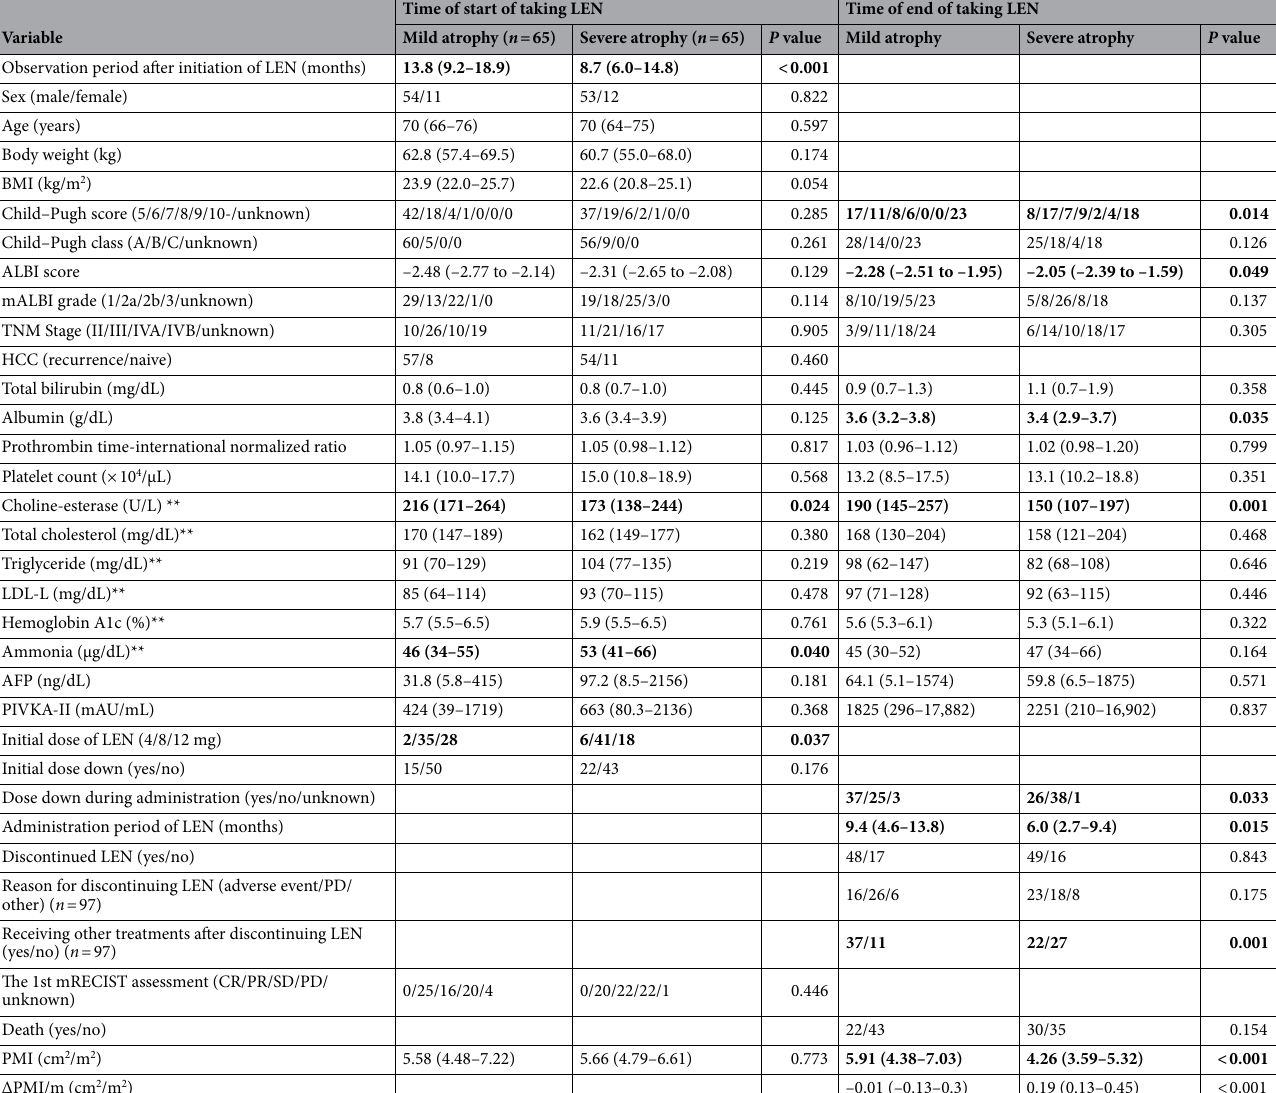
Table 4. Comparison between the severe and mild atrophy groups. Significant values are in [bold]. Values are presented as median (interquartile range). LEN lenvatinib, BMI body mass index, ALBI albumin-bilirubin, mALBI modified albumin-bilirubin, TNM tumor node metastasis, HCC hepatocellular carcinoma, LCL-C low density lipoprotein cholesterol, AFP alpha fetoprotein, PIVKA-II protein induced by Vitamin K absence or antagonists-II, PD progressive disease, mRECIST Modified Response Evaluation Criteria in Solid Tumors, CR complete response, PR partial response, SD stable disease, PMI psoas muscle index, ΔPMI/m change in PMI per month. Severe atrophy group: ΔPMI/m rate ≥ 1%, Mild atrophy group: ΔPMI/m rate < 1%. (ΔPMI/m rate: rate of change in PMI per month during administration of LEN). **Calculated using the available